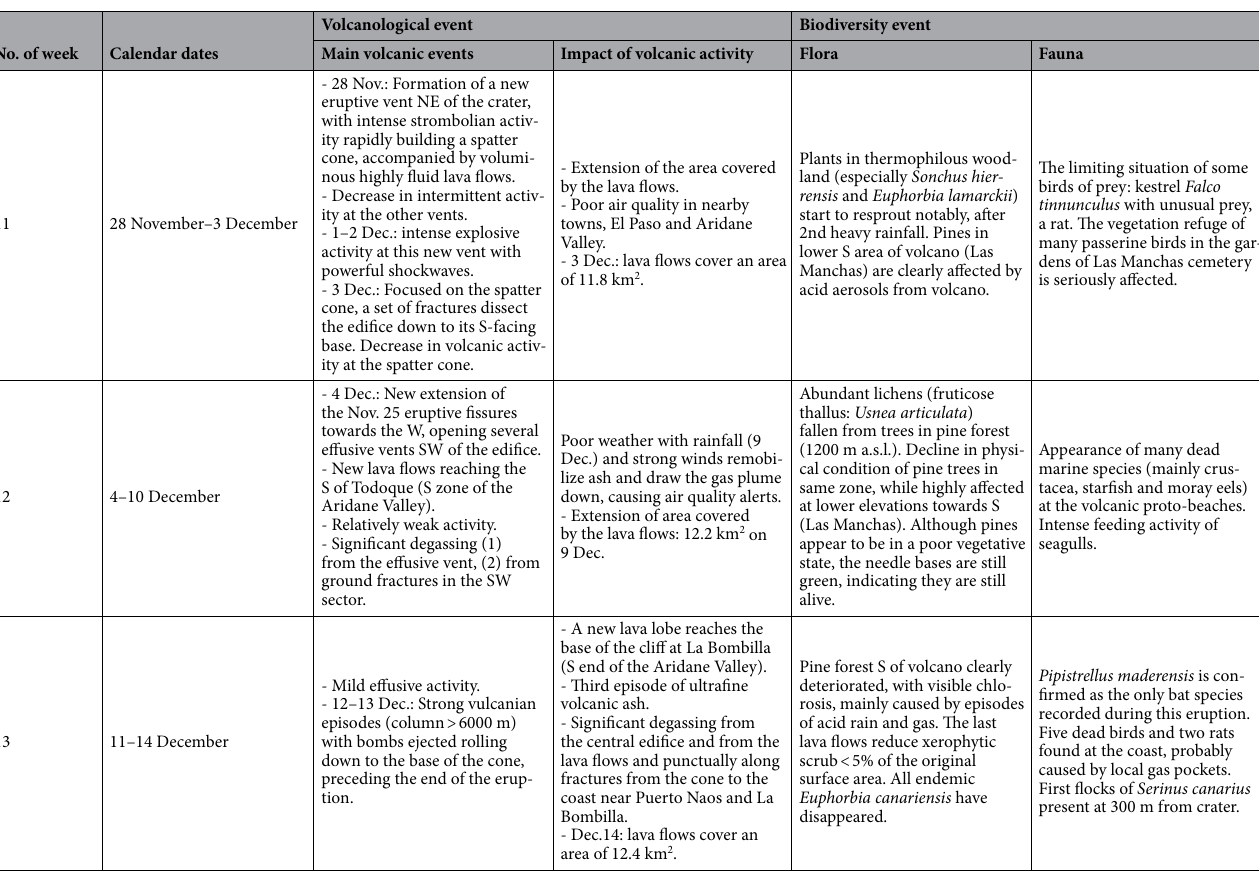
Table 1. Weekly chronology of the main volcanological and terrestrial biodiversity events recorded during the eruption at Hoya de Tajogaite (La Palma, Canaries). Areas covered by lava flows were determined by Copernicus